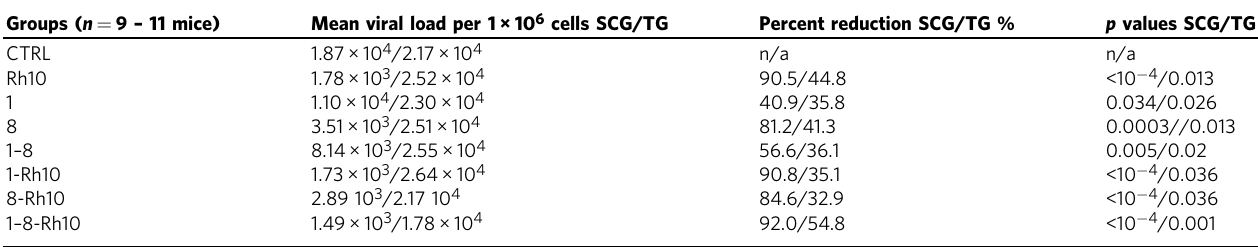
Table 2 HSV loads after delivery of dual-meganuclease therapy using AAV combinations. Groups ( n = 9 – 11